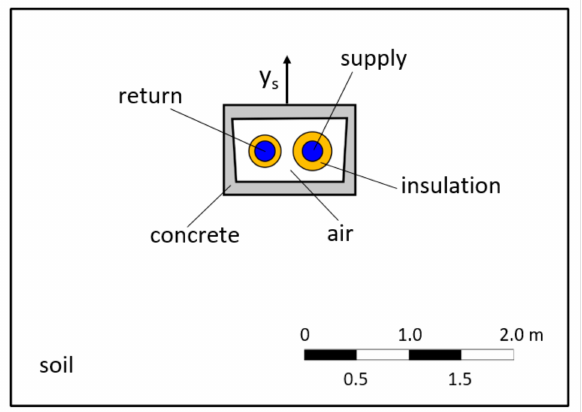
Figure 1. Domain geometry, where y s stands for the soil